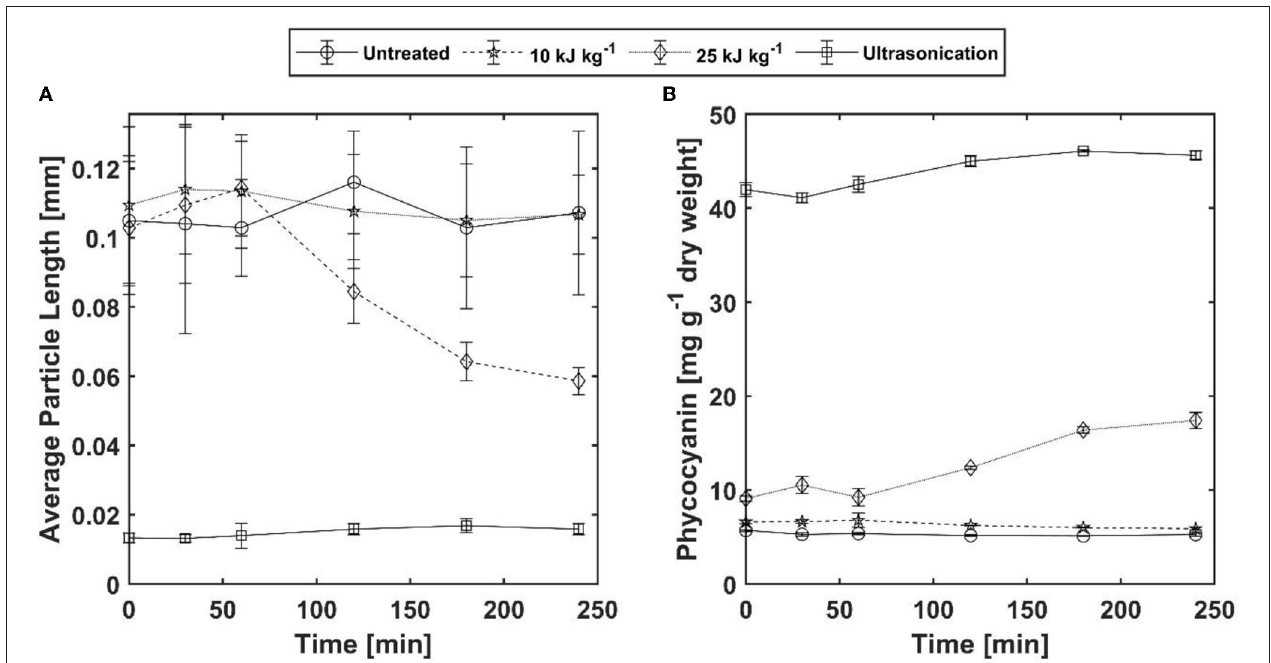
FIGURE 8 | Comparison between decay of A. platensis trichomes and phycocyanin extraction yield for one untreated (Sample 0), two PEF-treated [samples (A,B) ], and one ultrasound-treated sample (sample US). The PEF treatments [ (A) 10 and (B) 25 kJ kg − 1 ] were both carried out at 40 ◦ C and 20 kV cm − 1 with different pulse counts (8 and 32 pulses respectively). Left: Changes in average particle size over a period of 240min. The error bars indicate the variation of particle length for all detected particles. Right: Phycocyanin extraction over the same time. The error bars indicate the standard deviation from two independent